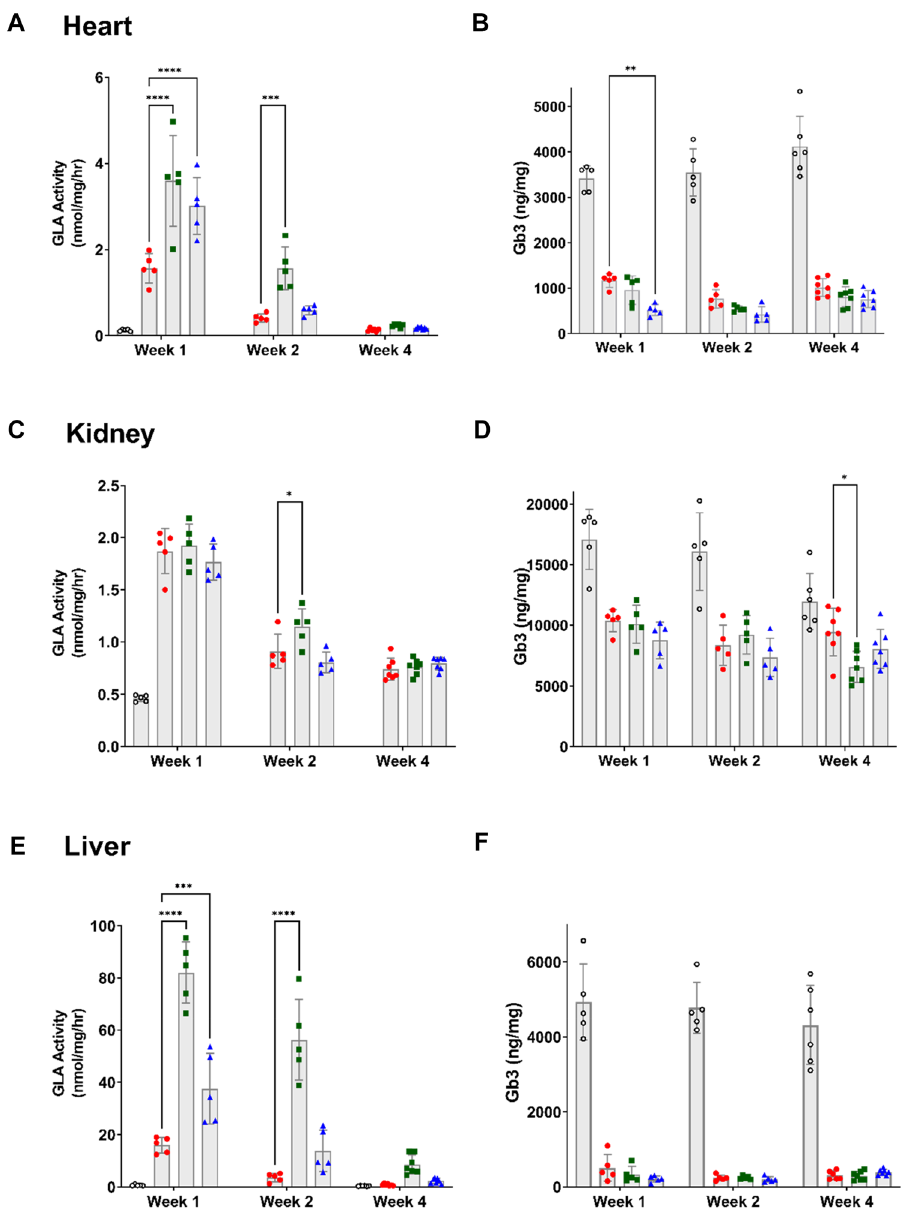
Figure 5. Pharmacodynamics (PD) alpha galactosidase activity and Gb3 accumulation after exposure to GLA variants. 5-month-old female GLA −/− mice were dosed with GLA variants at 1 mg/kg i.v. At indicated timepoints, the mice were sacrificed, perfused, and tissues were harvested: liver ( A , B ), heart ( C , D ), and kidney ( E , F ). Tissues were processed and tested for alpha galactosidase activity ( A , C , E ) and Gb3 ( B , D , F ). Note that alpha galactosidase activity in liver is considerably higher than for other organs. *p < 0.05, **p < 0.01, ***p < 0.001, ****p < 0.0001—two way ANOVA with Dunnett multiple